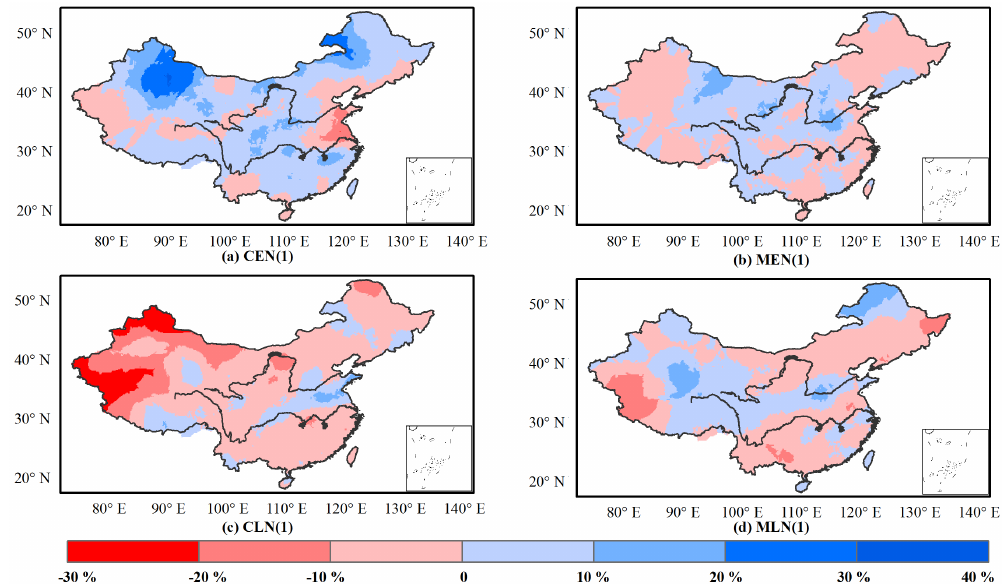
Figure 4. Spatial pattern of precipitation anomalies during rainy season (PARS) for decaying (1) conventional ENSO and ENSO Modoki